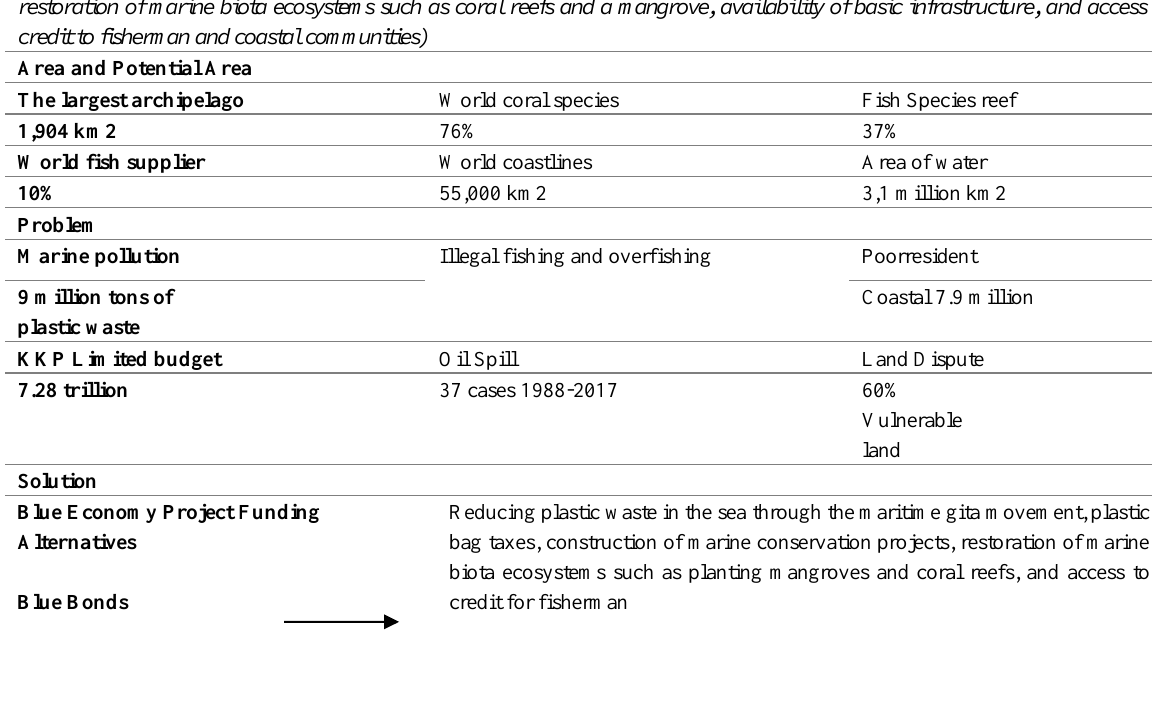
Table 3: Publishing Matrix Bluebonds (Author